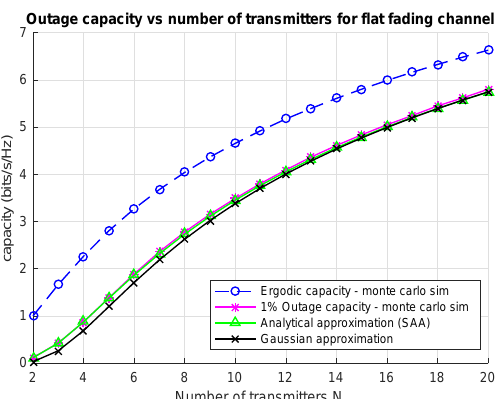
Figure 9. Ergodic capacity and 1% outage rates (b/s/Hz) versus number of nodes for narrowband flat fading channel at SNR = − 5 dB.